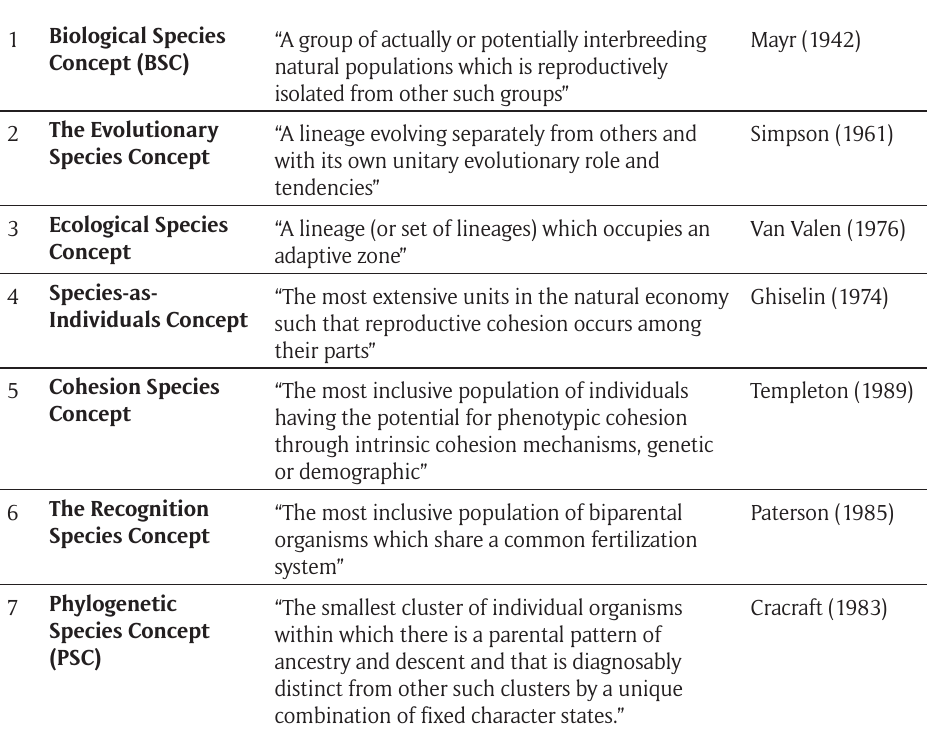
Table 1: derived from species concepts outlined in Groves (2004: